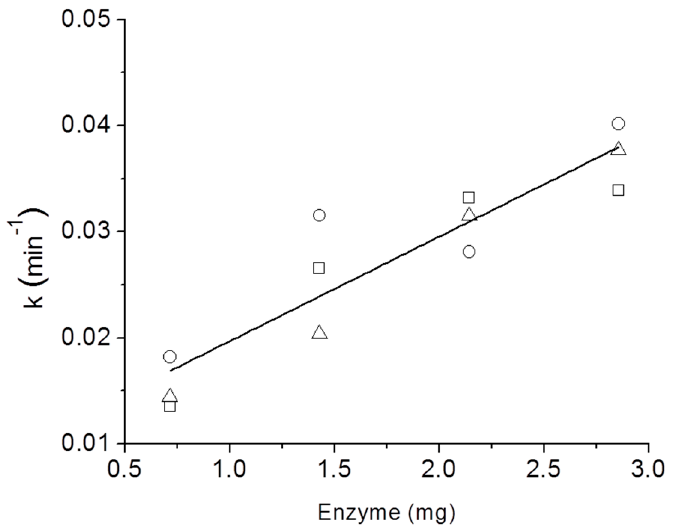
Figure 10. First order rate constant k * of the enzymatic hydrolysis of QDA by lipase as a function of the amount of supported lipase added (Novozym 435) converted to enzyme mass in three apolar solvents. cyclohexane ( ○ ), decalin ( Δ ) and hexane ( □ ). Solution volume of 3 mL, T = 298 K.